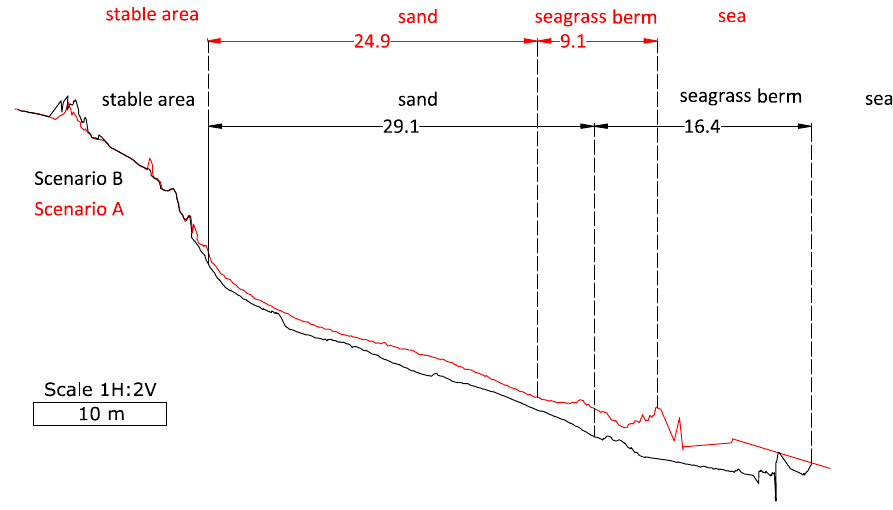
Figure 7. Representative profile number 5 for the two studied scenarios/sampling dates (A: 24 November 2016, and B: 22 March 2017. Note that the vertical scale is twice the horizontal. The limits of the stable area, sand area, and seagrass berm are displayed in the figure.